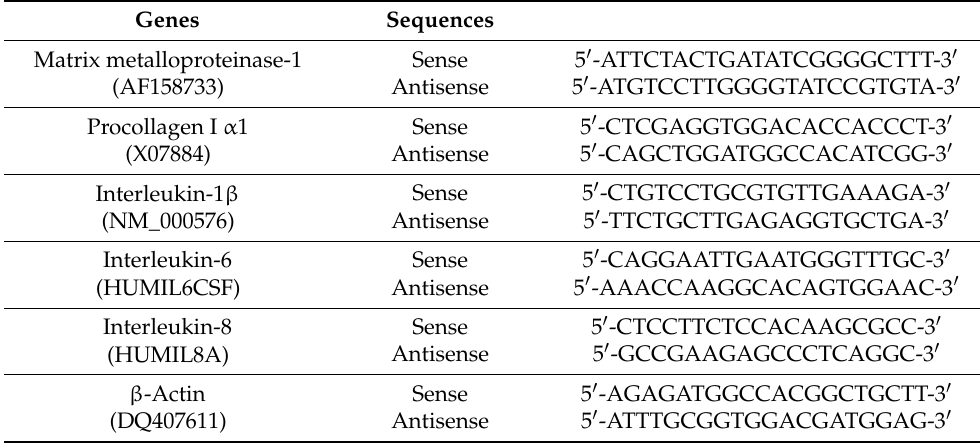
Table 1. List of primer